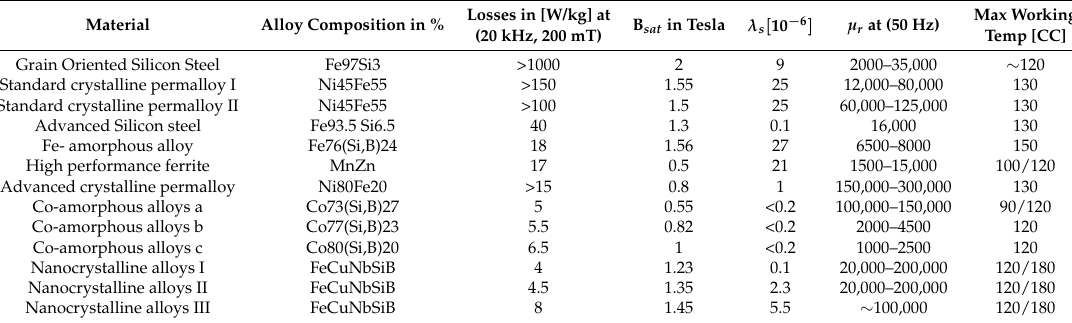
Table 2. Properties of selected soft magnetic materials